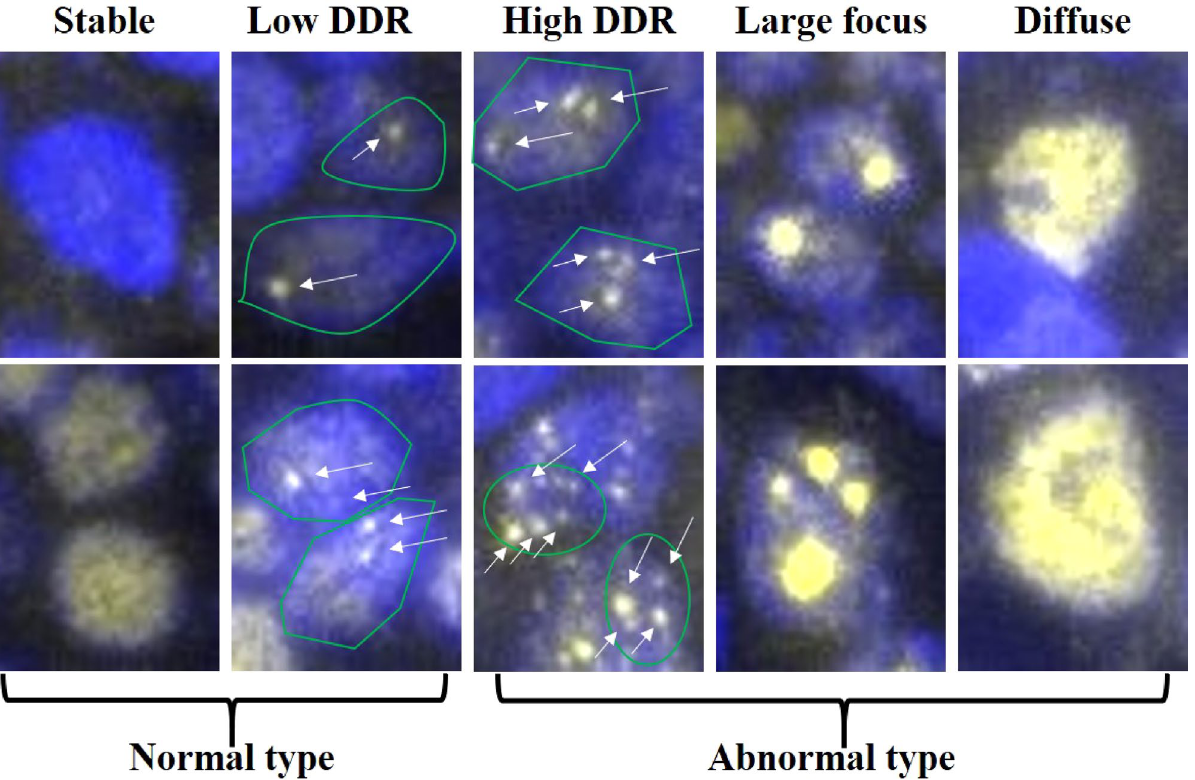
Figure 1. Types of 53BP1 expression patterns observed in lymphocytes by immunofluorescence. Stable type, no or weak staining; low DNA damage response (DDR), one or two nuclear foci (NF, indicated by arrows) with size < 1 µm; high DDR, three or more NF (indicated by arrows) with size < 1 µm; large focus, NF with size ≥ 1 µm; diffuse type, intense and heterogenous staining. Green line indicates the border of the nucleus. Images for 53BP1 expression were photographed with the Z-stack function of Biorevo BZ-X710 microscope (Keyence Japan, Osaka, Japan), and their signals were measured using the image analysis software provided with the Biorevo